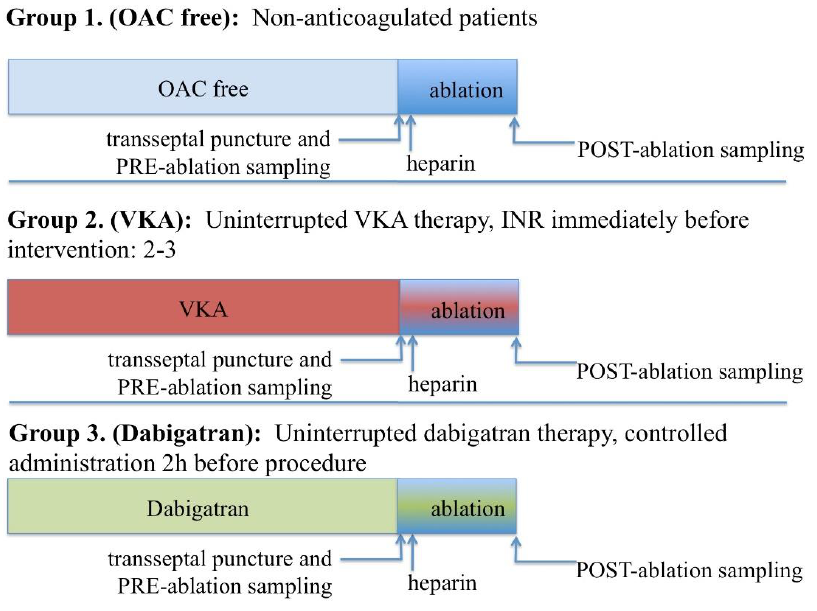
Figure 1. Study groups according to pre-procedural anticoagulation strategy. INR: International Normalised Ratio, OAC: oral anticoagulant, VKA: vitamin K antagonist.